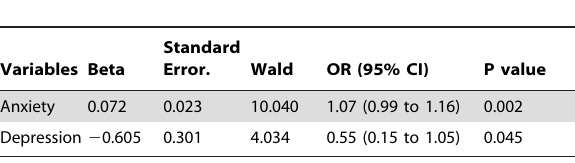
Table 5. Multivariate logistic regression to evaluate psychological factors of IBS.